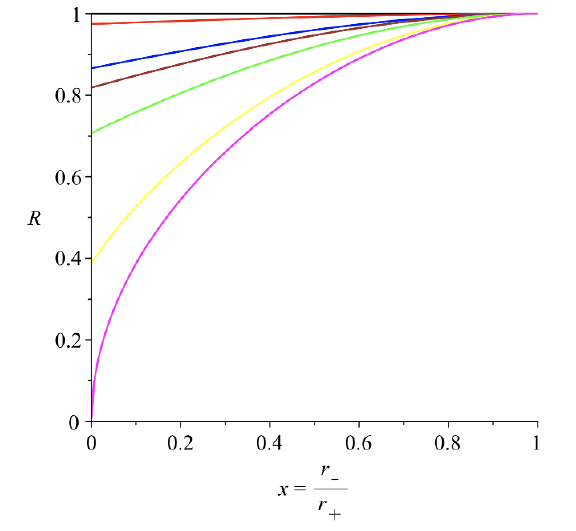
Figure 6 . Reverse isoperimetric ratio plotted as a function of x = r (cid:0) =r + for various values of ( (cid:11); (cid:13) ): (1 ; 0) (black), ( : 95 ; : 05) (red), ( : 75 ; : 25) (blue), ( : 67 ; : 33) (brown), (0 : 5 ; 0 : 5) (green) ( : 15 ; : 85) (yellow), (0 ; 1)